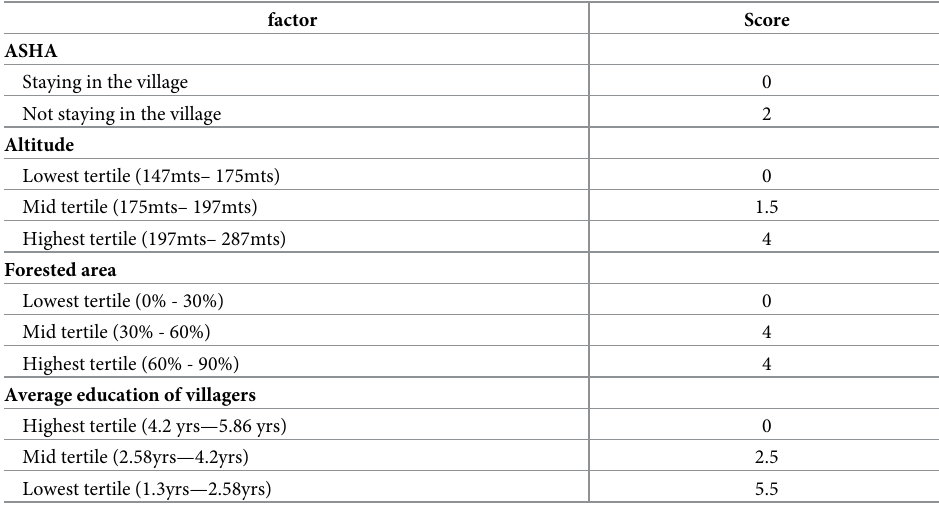
Table 5. Village risk